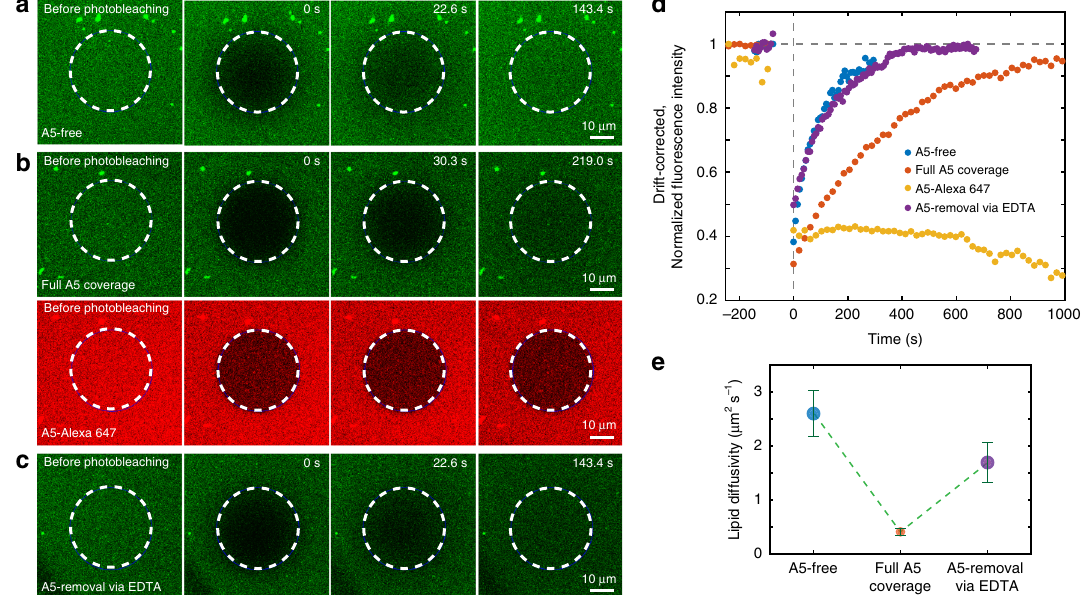
Fig. 4 A5 2D-lattice modulates the diffusivity of underlying lipids. a – c Consecutive fl uorescence recovery after photobleaching (FRAP) experiments on SLB membrane (DOPC/DOPS/NBD-PC 19:20:1) on glass measured in the conditions of a A5-free (SLB only), b full A5 coverage, and c A5-removal upon EDTA-addition. Two separate spectral channels with different excitation lasers were used to monitor NBD-PC and A5-Alexa 647 (mixture of A5:A5-Alexa 647 at a ratio of 2:1), respectively. The white dashed circles indicate the photobleaching area. d Time-lapse analysis of FRAP experiments within the photobleaching areas shown in a – c . The presence of the A5 2D-lattice slows down the fl uorescence recovery of the underlying membrane (orange). The A5 2D-lattice is stable and shows no fl uorescence recovery. e Calculated lipid diffusivity in the subsequent FRAP experiments. The formation of A5 2D- lattice decreases the mobility of underlying lipids, which was recovered by removing A5 molecules through EDTA-addition. Each data represent the mean ± s.d. (mean ± standard deviation) of n ≥ 10 FRAP